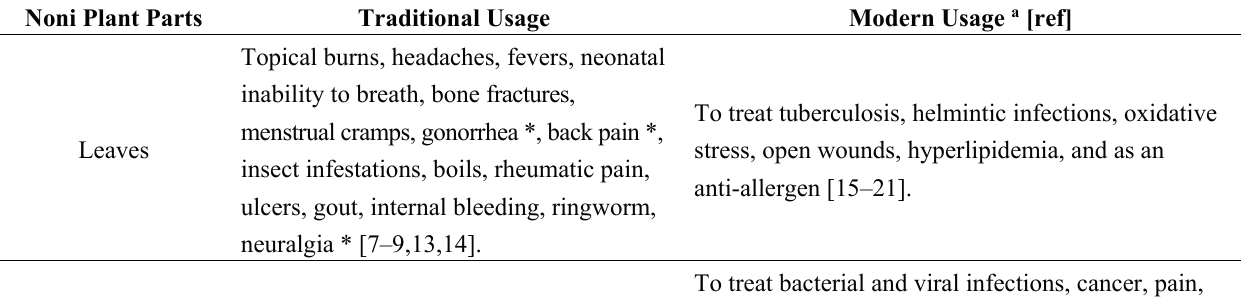
Table 1. Traditional and modern uses of